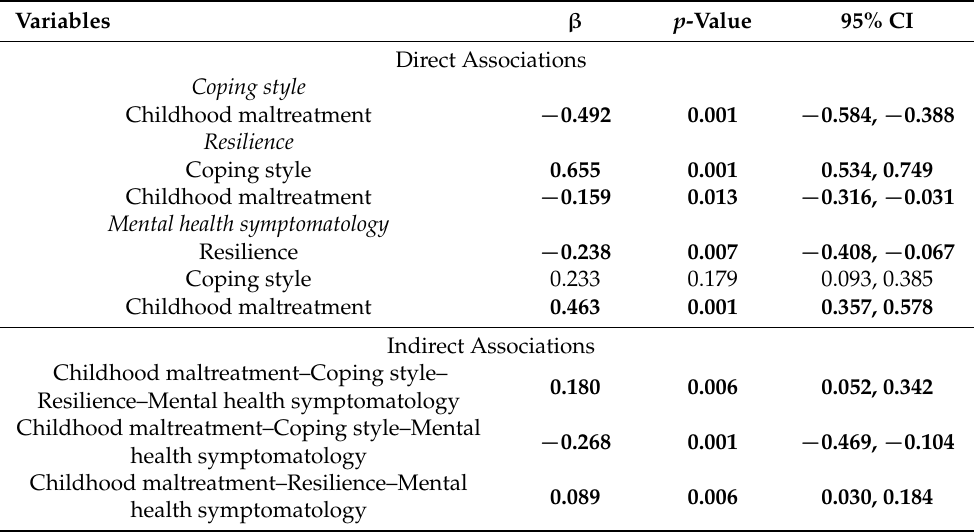
Table 2. Standardized direct and indirect association coefficients of the final model.